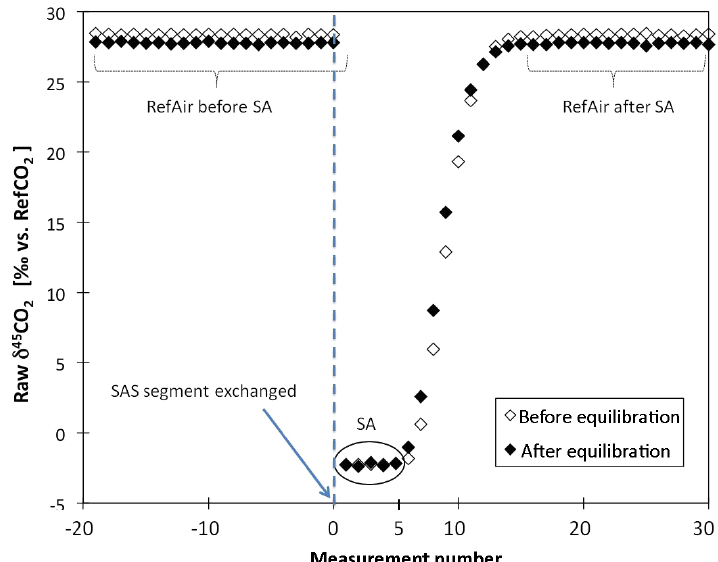
Figure 5. Raw- δ 45 CO 2 data (‰ vs RefCO 2 ) from a complete measurement sequence of an SASsegment. SA is the air sample stored in the